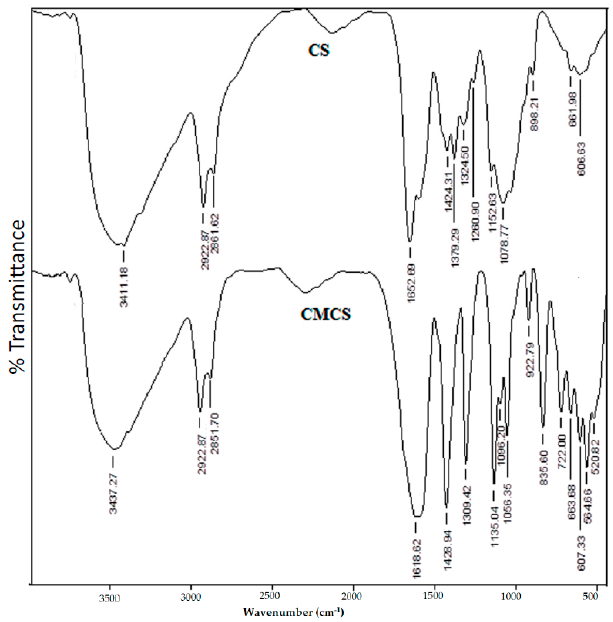
Figure 1. FTIR spectra of chitosan (CS) and carboxymethyl chitosan (CMCS).